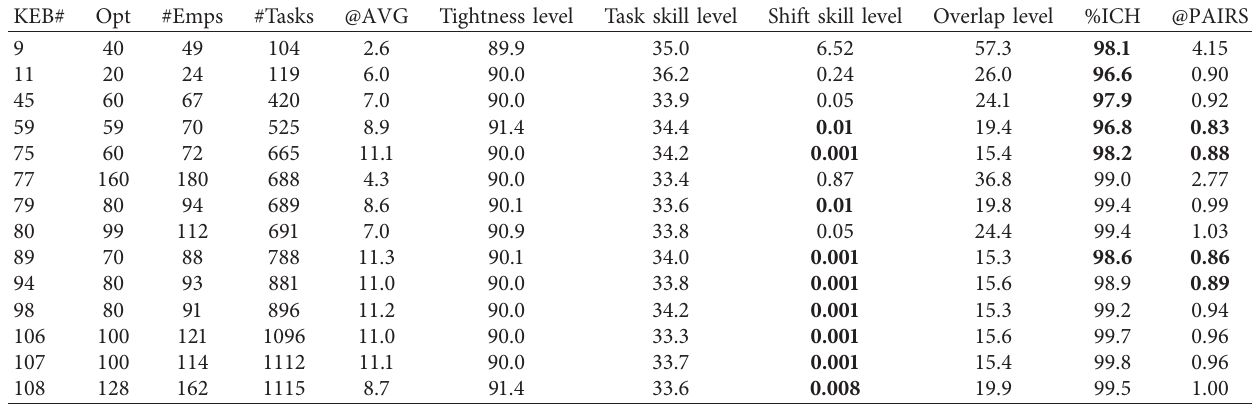
Table 1: The characteristics of the 14 KEB instances.